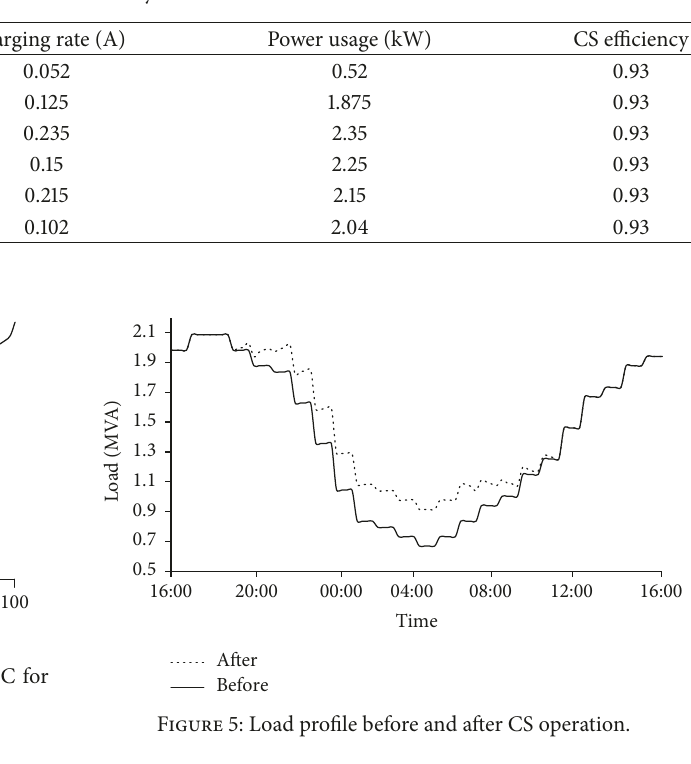
Table 2: CS and battery data.